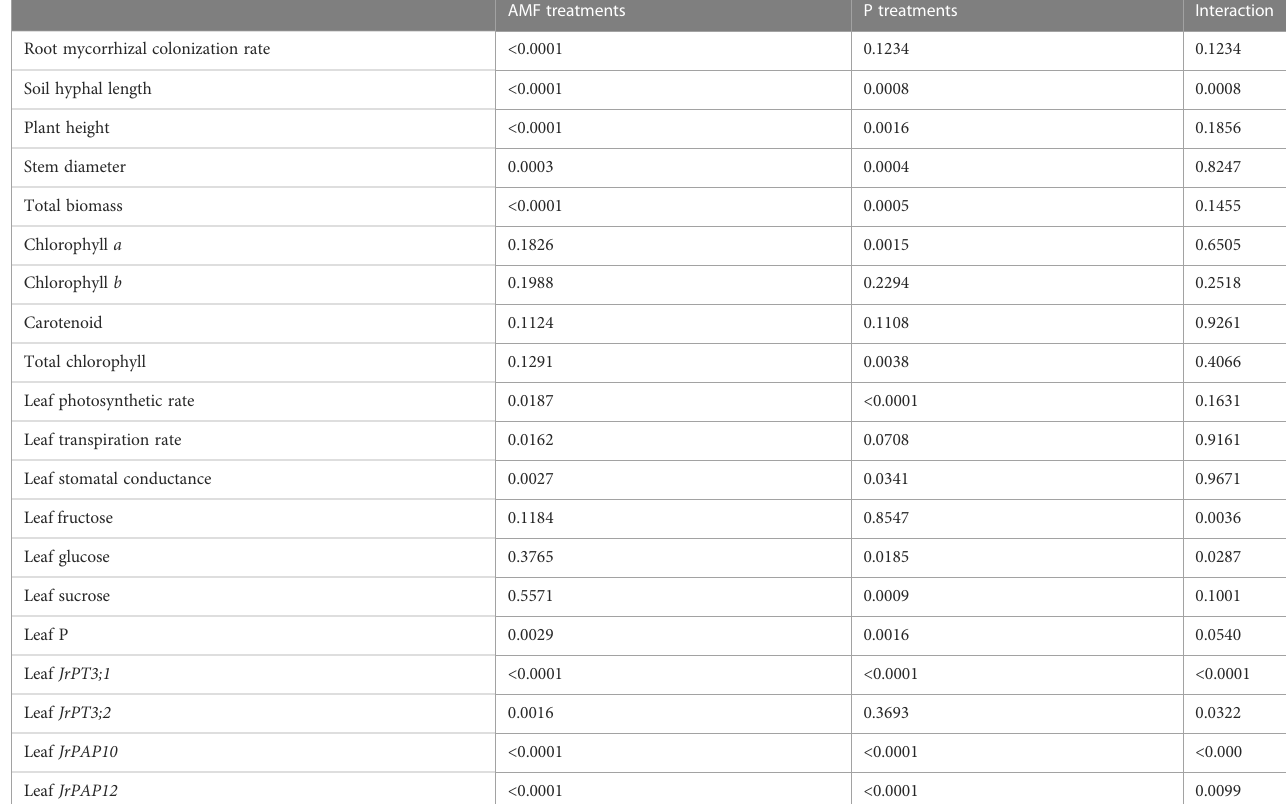
TABLE 1 Signi fi cance in interaction between arbuscular mycorrhizal fungi (AMF) treatments and phosphorus (P) treatments. AMF treatments P treatments Interaction